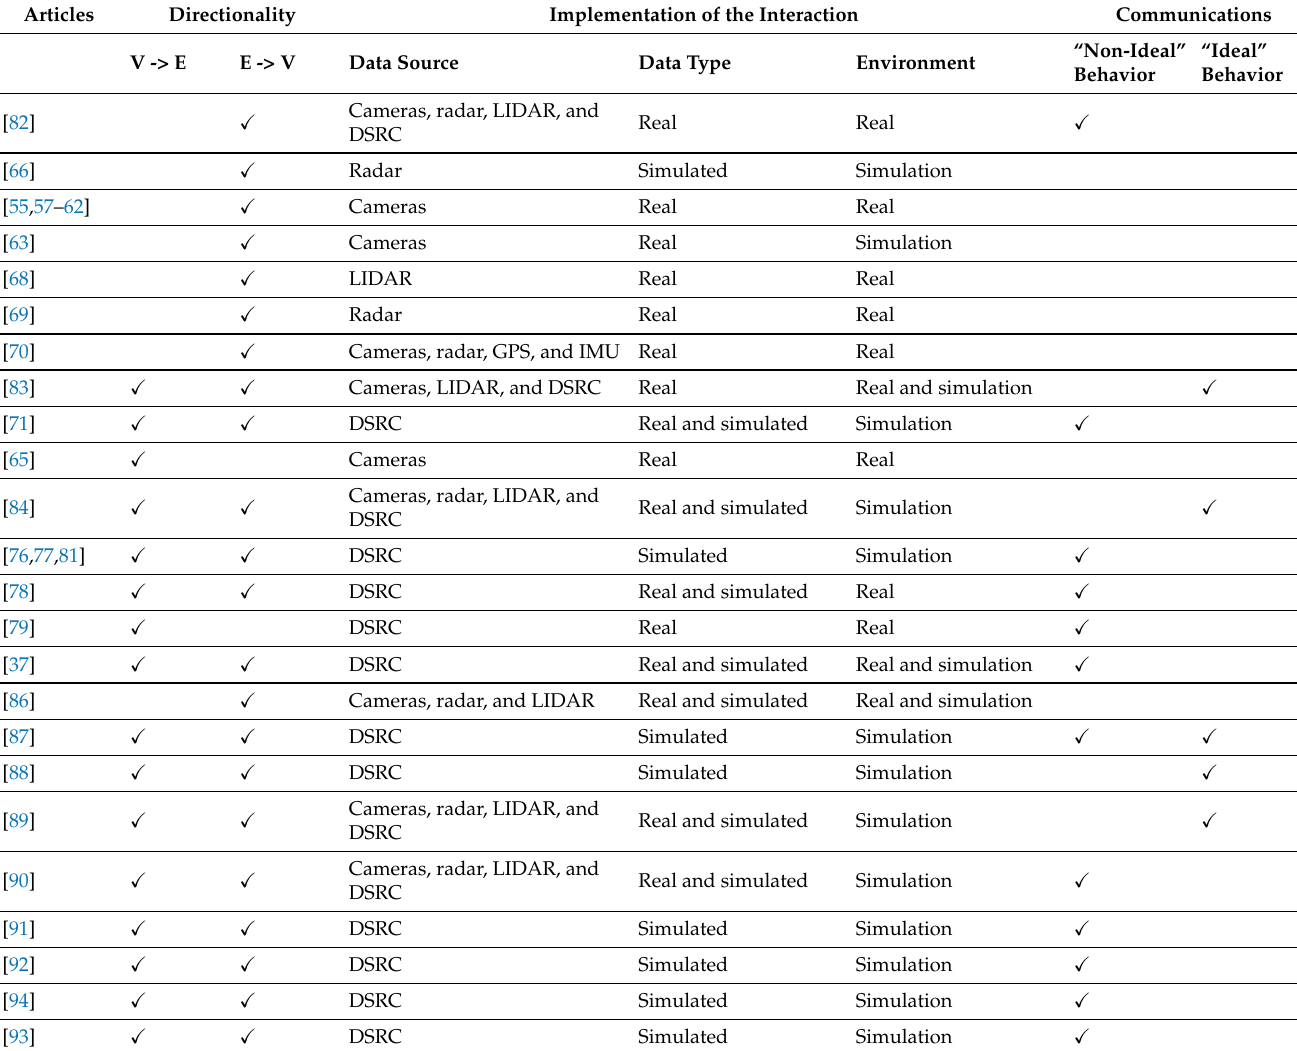
Table 3. Works in which vehicle–environment interaction is addressed. The “ideal” behavior means that the authors do not consider the losses of the communication channel. The works that are not grouped within “ideal” behavior or “non-ideal” behavior, are those in which the use of communica- tions is not considered for the design of